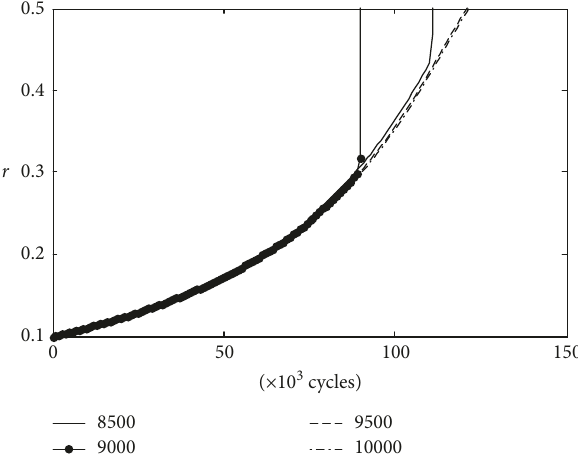
Figure 8: Crack growth evolutions for various rotation